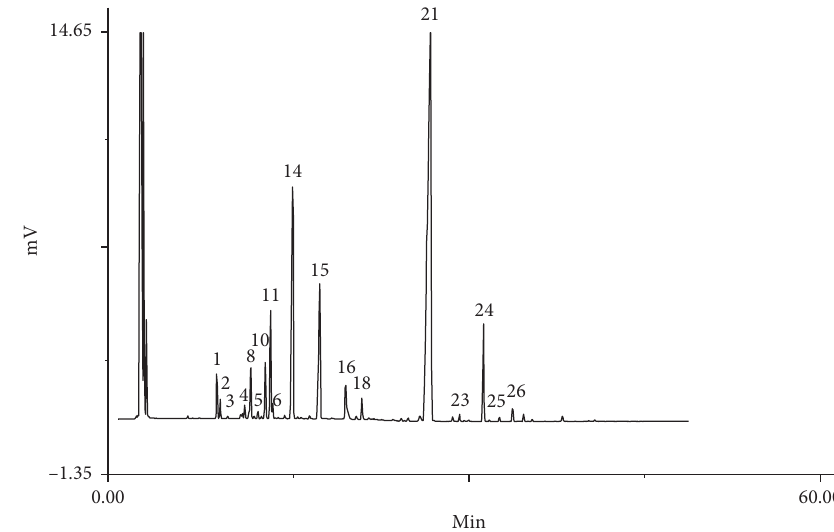
Figure 2: Gas chromatogram of the essential oil of O. vulgare grown at Pithoragarh